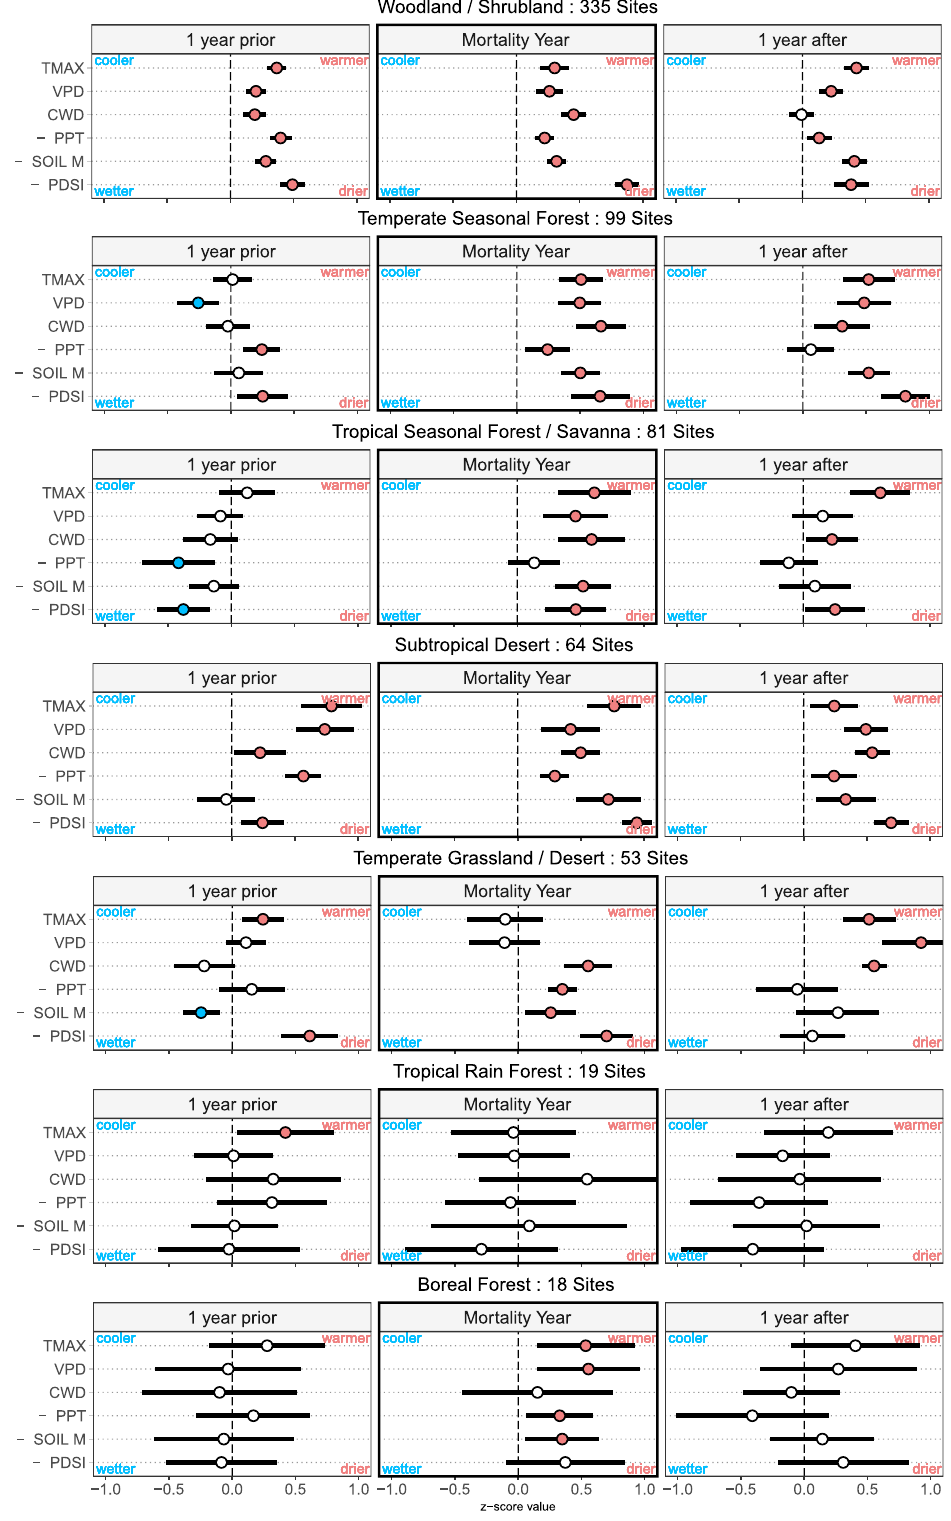
are uncertain 4,9,35 . In particular, during hotter-drought events, plant uptake of CO 2 is limited by the initial closing of stomata — with CO 2 uptake eventually blocked as leaves lose turgor, followed by failure of the coupled plant water-and-carbon transport system which may ultimately result in death 16,28 . Thus, potential amelioration of tree mortality risk by the ~85